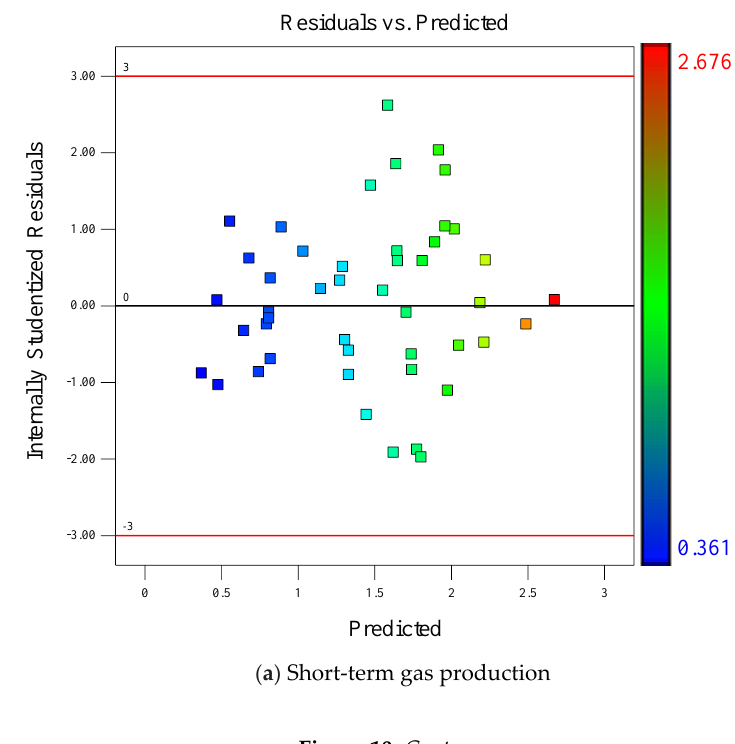
( a ) Short-term gas production Figure 10.